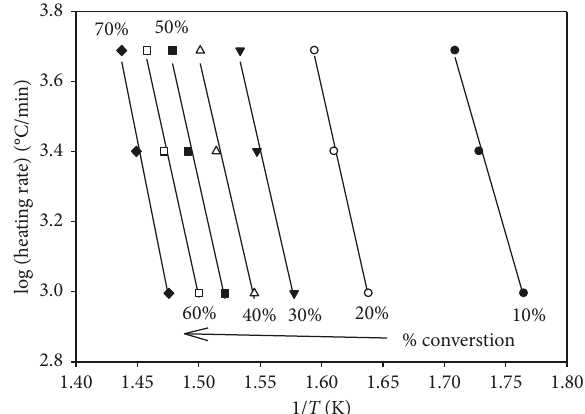
Figure 7: Log beta vs. 1/ T plots of TGA kinetics analysis of cot- tonseed oil+gluten +3g zinc chloride (data analyzed at 50%